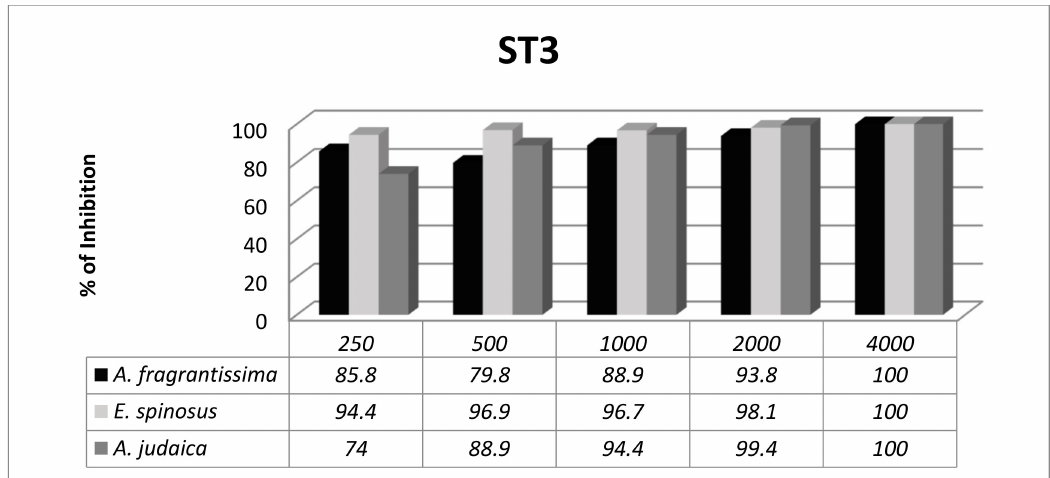
Figure 1. Active response of Blastocystis ST1 (percentage of growth inhibition) to di ff erent concentrations of the three herbal extracts at 72 h.